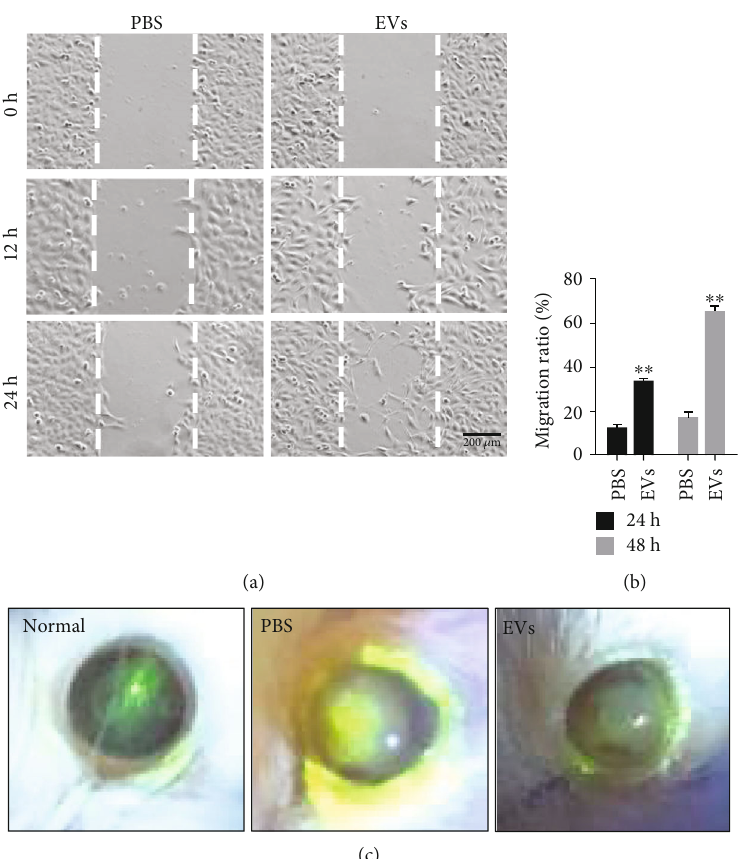
Figure 3: The therapeutic e ff ects of EVs on corneal wound healing . (a, b) Wound healing assay revealed that EVs markedly increased the cell migration of HCEs. All data were shown as means ± SEM in triplicate assays. ∗∗ P < 0 : 01 versus PBS. (c) Fluorescein-stained images showed the improved therapeutic e ff ect of EVs on corneal wound healing in vivo ( n = 8